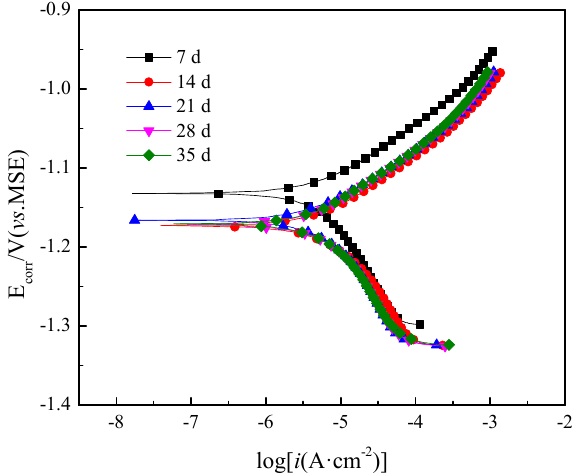
Figure 7. Polarization curves of Q235B steel in desulfurization solution with different immersion time.